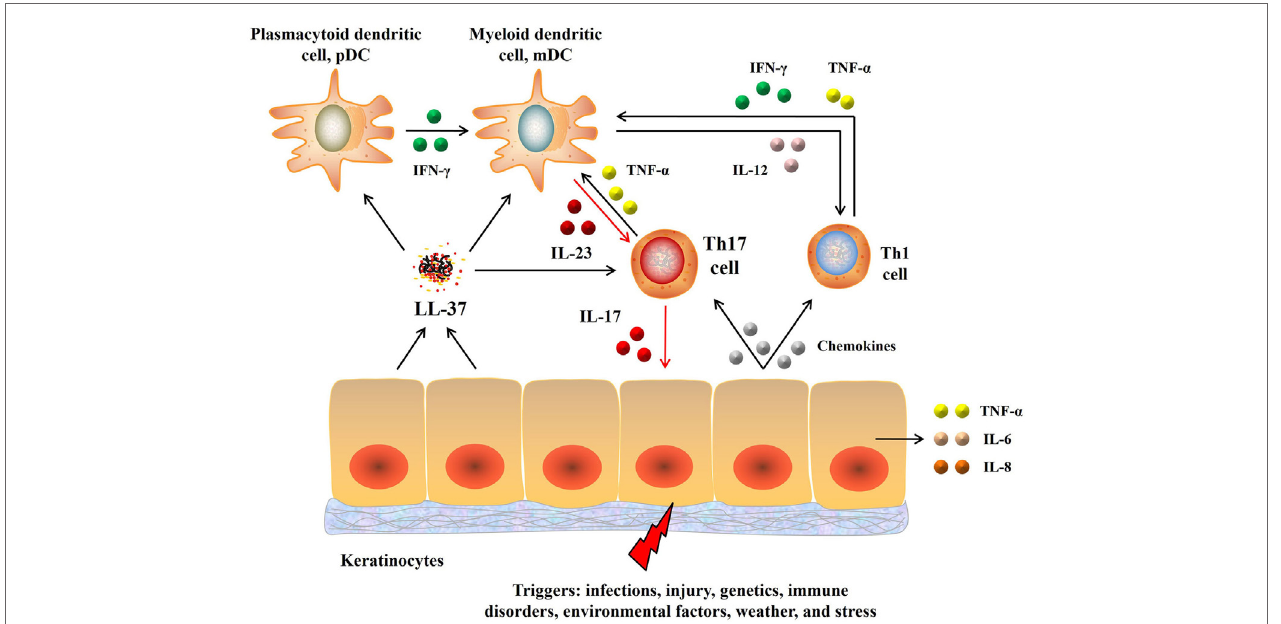
FiGURe 1 | Pathogenesis of psoriasis. Upon activation, keratinocytes secrete LL-37 that in turn activates dendritic cells, which then produce IL-23 and IL-12. IL-23 induces differentiation of naive T cells into Th17 cells that then overproduce IL-17 and IL-22. IL-17 activates keratinocytes, promotes epidermal hyperplasia and recruits proinflammatory cells, resulting in a positive proinflammatory feedback that accelerates the development of psoriasis. Moreover, IL-12 produced by dendritic cells also promotes the differentiation of Th1 cells that in turn produce Th1 cytokines, including IFN- γ . Abbreviations: IL, interleukin; TNF, tumor necrosis factor; IFN- γ , interferon- γ ; Th17, T helper 17; IL-23, interleukin-23; IL-17,